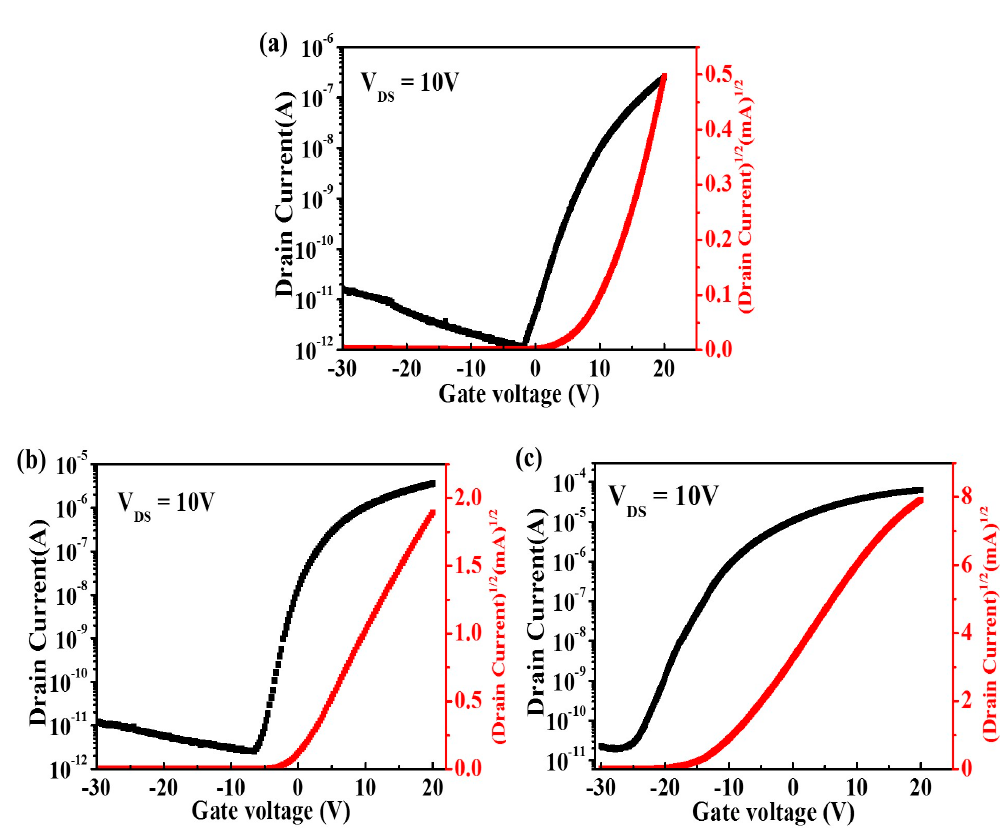
Figure 2. Logarithmic and linear scale of transfer characteristic curves for samples ( a ) A, ( b ) B, and ( c ) C. Table 1. Electric properties of MgInO under different target power values of In 2 O 3 .